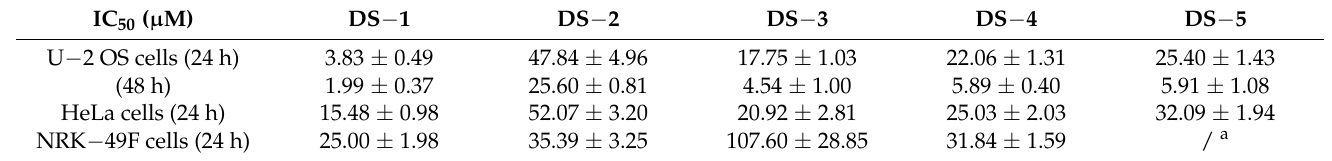
Figure 2. Danshinones inhibited cell proliferation. Cell viability of tanshinone-treated ( A ) U − 2 OS cells, ( B ) human cervical carcinoma HeLa cells, and ( C ) normal rat kidney cells NRK − 49F. Cancer cells were seeded in a 96-well plate and cultured in the desired tanshinone drugs at different concentrations for 24 and 48 h, and the survival rate was detected by an MTT essay. Data are the mean ± S.D. from three independent experiments with similar results. Table 1. The IC50 values of tanshinones to U − 2 OS cells, Hela cells, and NRK − 49F cells.